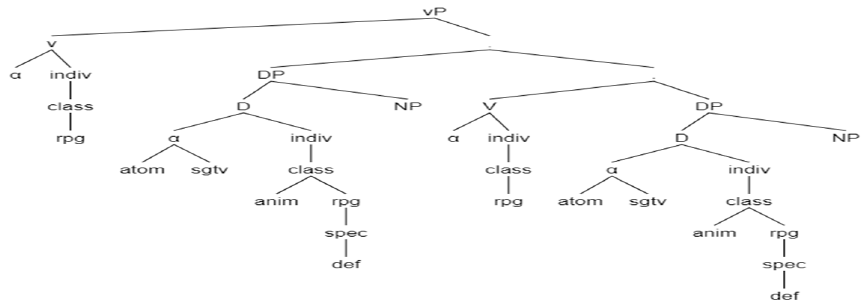
Figure 14. Geometry of the step 3 and the step 4.